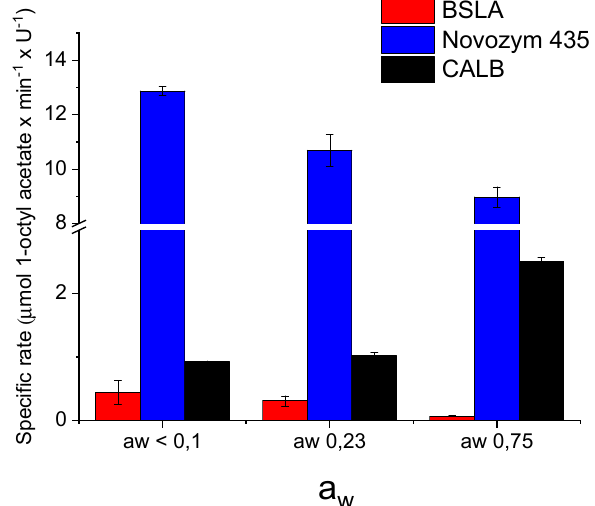
Figure 5. Activity of BSLA, CALB and Novozym 435 in toluene with different a w . Reaction conditions: 0.5–1.2 U of catalyst, 100 mM 1-octanol, 500 mM vinyl acetate, 500 mM decane (ISTD), in dry toluene (1 mL reaction) at 30 ◦ C and 1000 rpm. U: µ mol butyric acid × min − 1 . Blanks were performed in the absence of enzyme and showed no conversion.